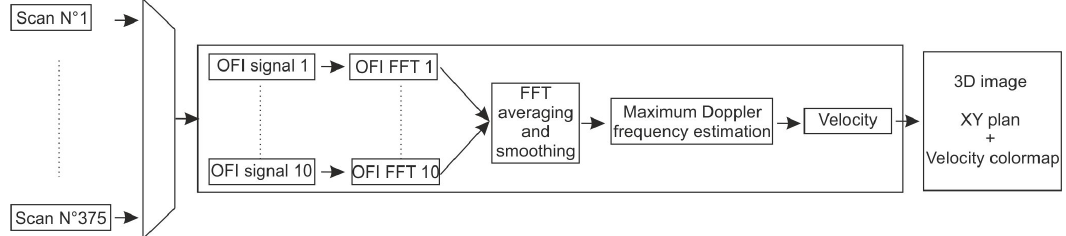
Figure 23. Signal processing block.